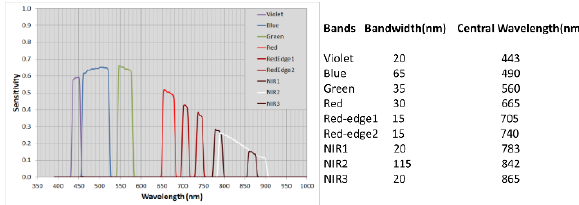
Figure 2. The sensitivity of optical bands of MAIA S2 cameras (Nocerino et al.,